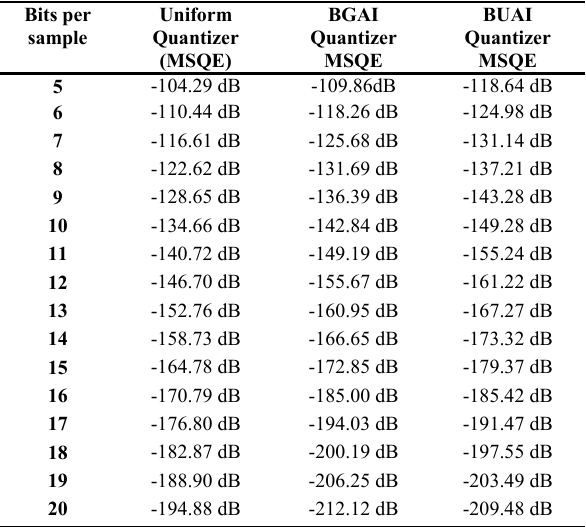
Table 1: The comparison among calculated MSQE of proposed methods and uniform quantizer.